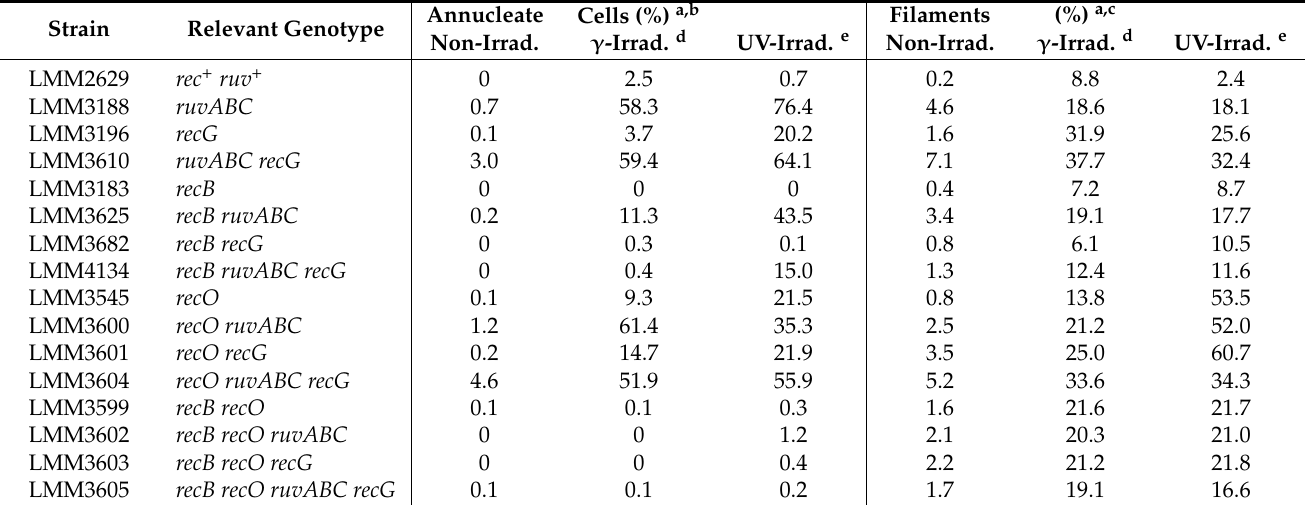
Table 3. Formation of annucleate cells and filamentats in different E. coli mutants following γ - or UV-irradiation. Statistical analysis is provided in Tables S7 and